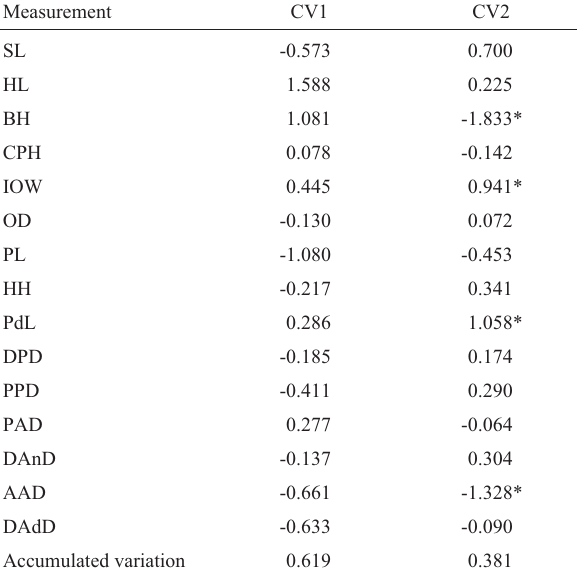
Table 2 - Analysis of canonic variables (CV) based on morphometric data of Astyanax fasciatus populations from two collection sites in the Contas River basin (Contas and Preto do Costa Rivers) and one site in the Recôncavo Sul basin (Mineiro Stream), State of Bahia, Brazil. For de- scription of measurements see Material and Methods.